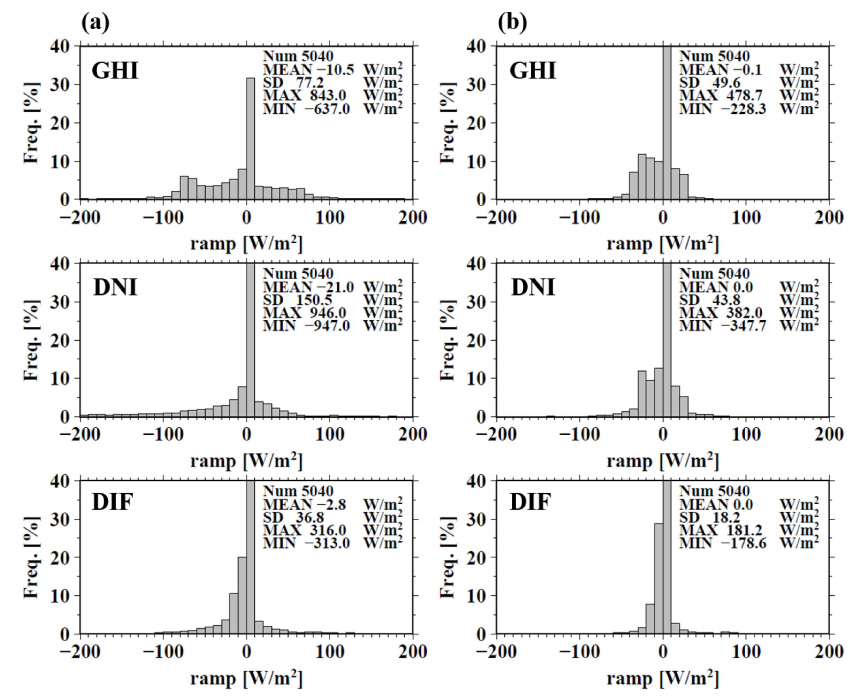
Figure 13. Same as Figure 12, frequency of solar radiation ramp rate in the winter season of